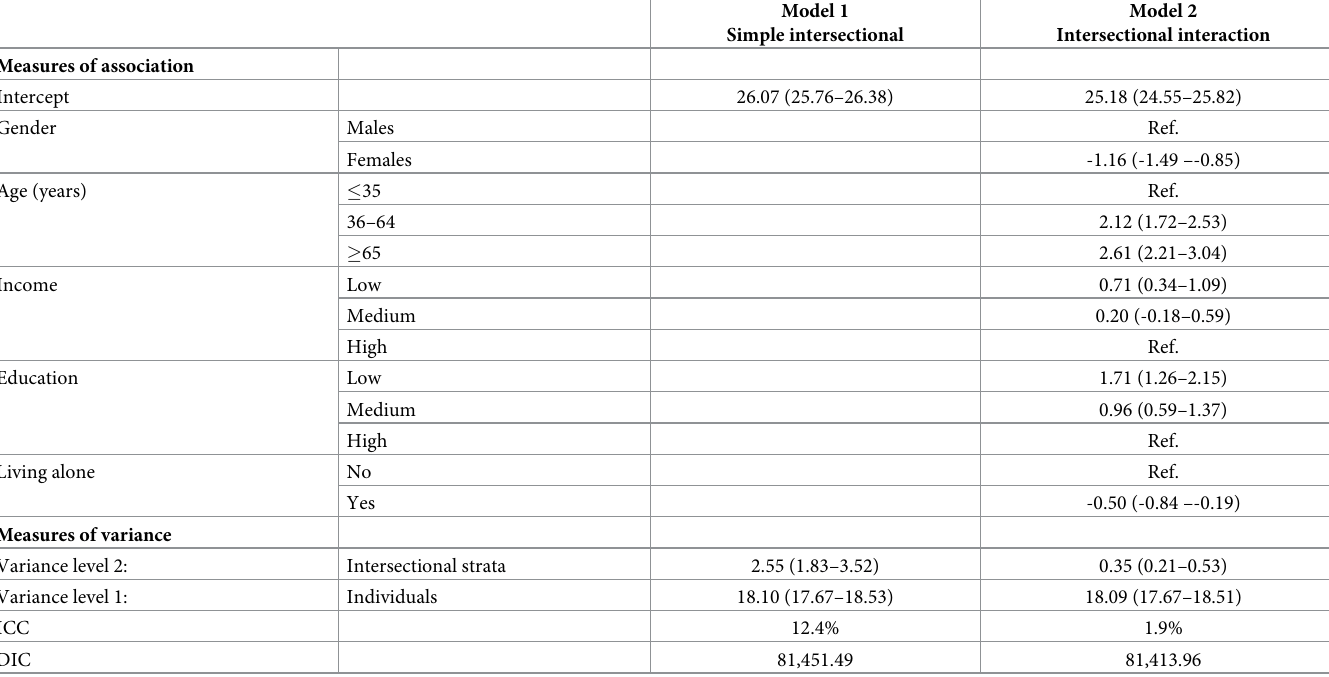
Table 2. Results from the multilevel linear regression